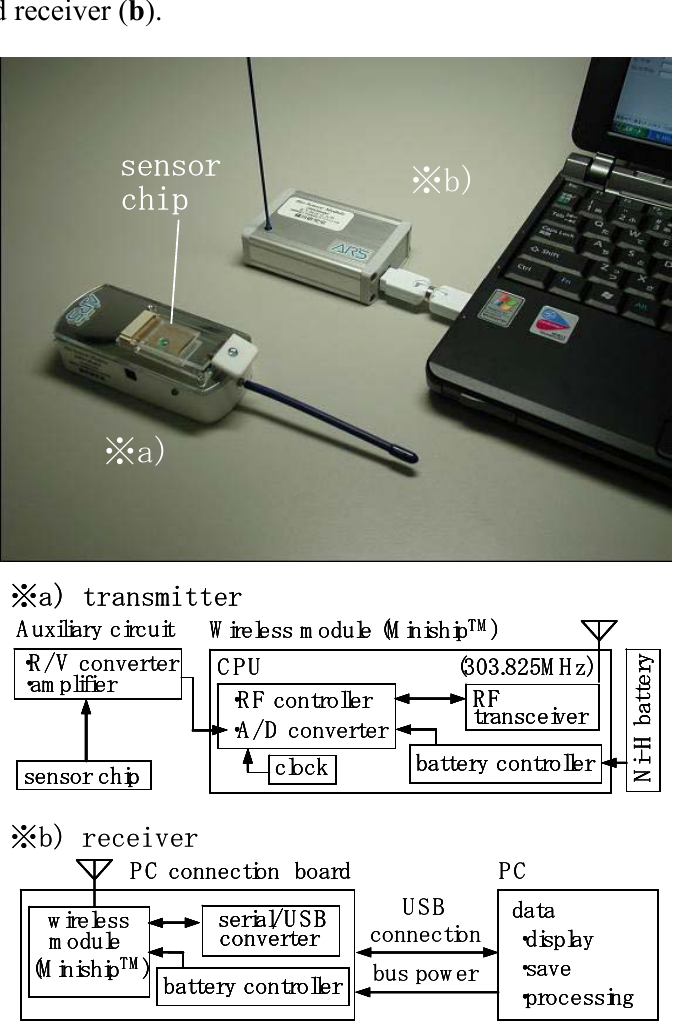
Figure 4. Wireless sensor signal analyzer system for the electrode chips. System flow of transmitter ( a ) and receiver ( b